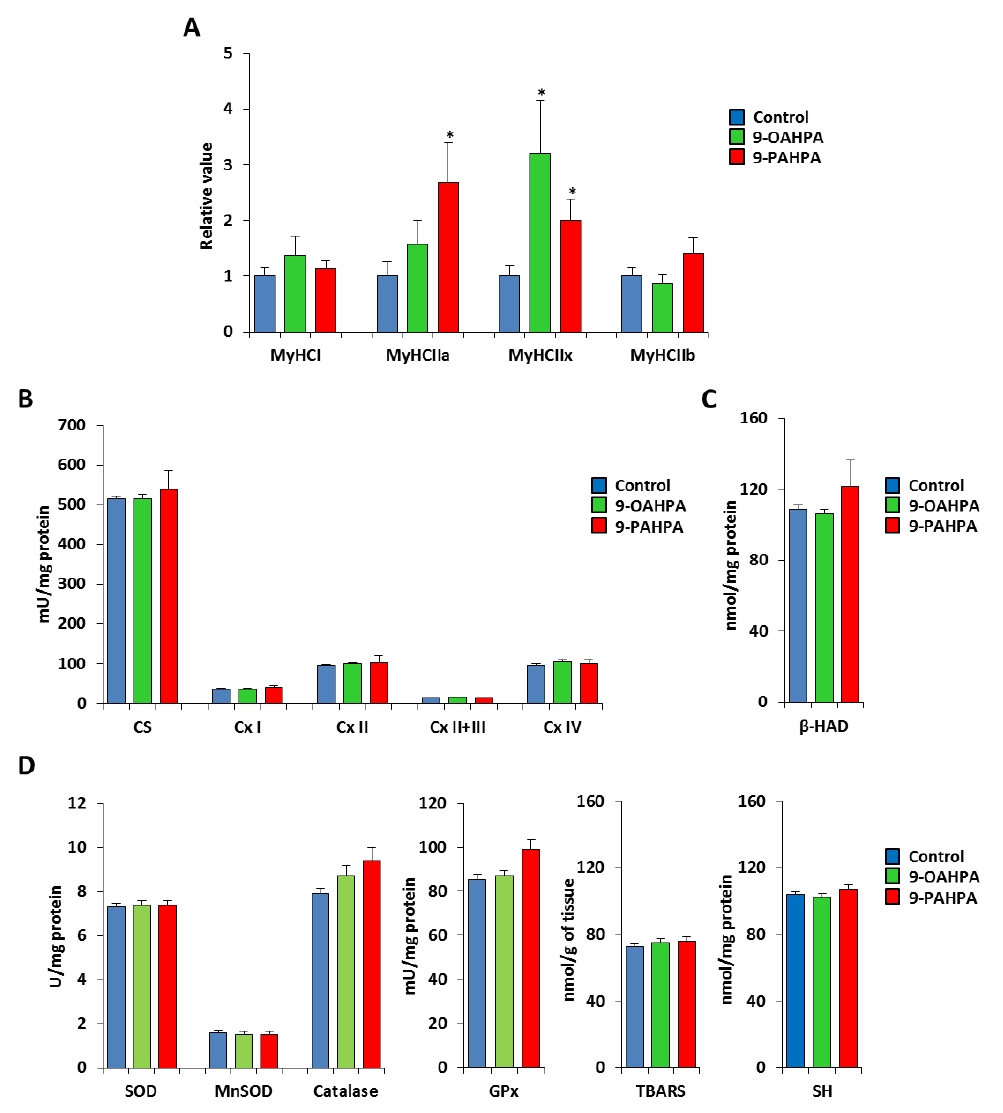
Figure 7. Influence of long-term intake of 9-OAHPA and 9-PAHPA on metabolic and contractile features of skeletal muscle. ( A ) Relative mRNA expression levels of the 4 adult MyHC isoforms in the tibialis muscle ( n = 10 for each group). ( B ) Mitochondrial enzymatic activities (n = 10 for each group). ( C ) β -HAD enzymatic activity ( n = 10 for each group). ( D ) Analysis of antioxidant enzymes (SOD, Mn-SOD, catalase, and glutathione peroxidase) and markers of oxidative stress (TBARS and SH-group; n = 10 for each group). SOD, total superoxide dismutase; MnSOD, manganese superoxide dismutase; GPx, glutathione peroxidase; SH, thiols; TBARS, thiobarbituric acid. Statistical significance: * p < 0.05 vs. control. Student’s t -test. Results are expressed as means ± SEM.